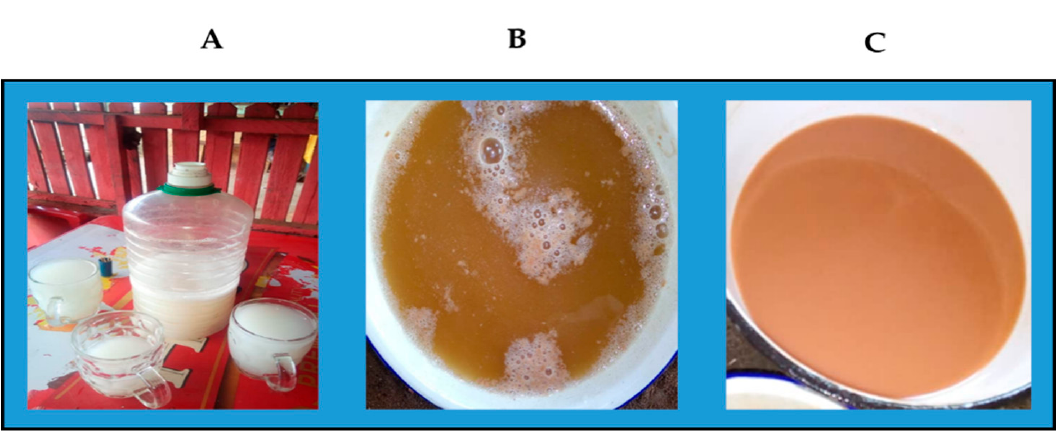
burukutu ( C ) are sometimes sold in makeshift open bars.